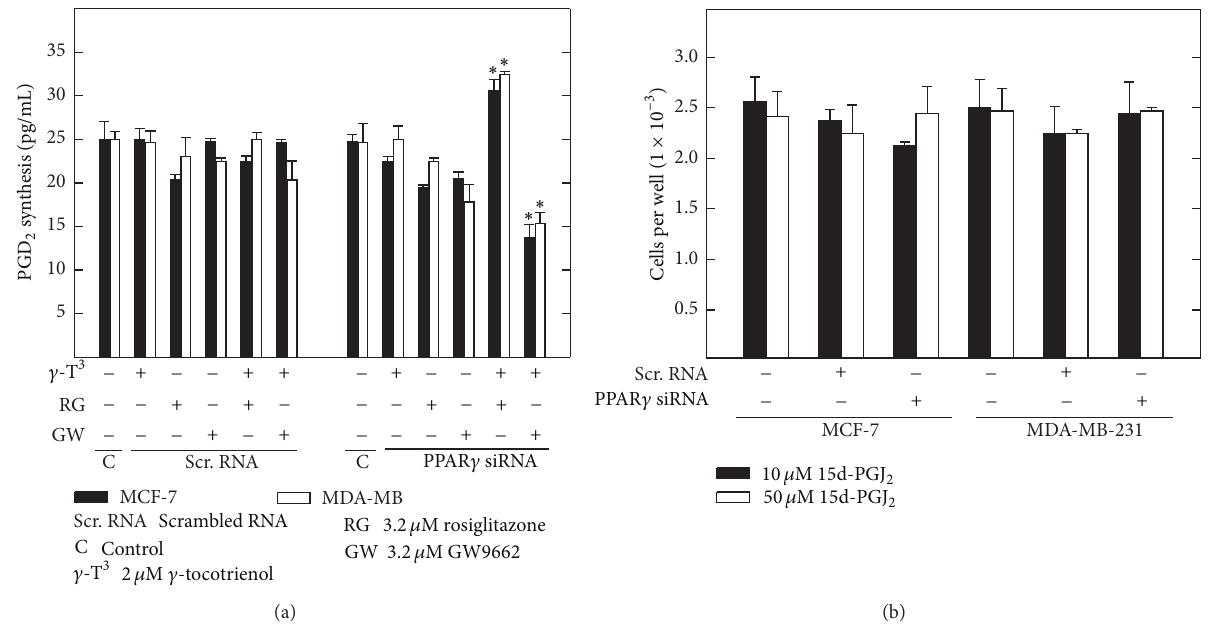
Figure 10: (a) Effect of 𝛾 -tocotrienol, rosiglitazone, and GW9662 given alone or in combination on PGD 2 synthesis and (b) treatment effect of 15d-PGJ 2 in PPAR 𝛾 positive MCF-7 and MDA-MB-231 cells. MCF-7 and MDA-MB-231 cells were plated at a density of 2×1 0 5 cells/well (3 replicates per group) in 6-well plates in 2mL antibiotic-free media. Transfections were performed using 5 𝜇 L lipofectamine 2000 according to the manufacturer’s protocol. Briefly, for each well to be transfected, 100pmol of the scrambled or PPAR 𝛾 siRNAs was diluted with 2mL of media. After 6 h transfection, the medium was replaced with fresh growth media containing 10% FBS and cells were cultured for 18 h. Cells were then exposed to control or treatment media for a 4-day culture period. Afterwards whole cell lysates were assayed for PGD 2 according to the manufacturer’s protocol. Vertical bars indicate the amount of PGD 2 synthesized (pg/mL) ± SEM in each treatment group. For 15d-PGJ 2 effect, MCF-7 and MDA-MB-231 cells were plated at a density of 2 × 1 0 4 cells/well (3 replicates per group) in 96-well plates and allowed to adhere overnight. Transfections were performed using 0.25 𝜇 L lipofectamine 2000. For each well of cells to be transfected, 5 pmol of the scrambled or PPAR 𝛾 siRNAs was diluted with 100 𝜇 L of media. After 6 h transfection, the medium was replaced with fresh growth media containing 10% fetal bovine serum and cells were cultured for 18 h. Cells were then exposed to 100 𝜇 L of control or treatment media for a 4-day culture period. Afterwards viable cell number was determined using MTT colorimetric assay. Vertical bars indicate mean cell count ± SEM in each treatment group. ∗ 𝑃 < 0.05 as compared with vehicle-treated